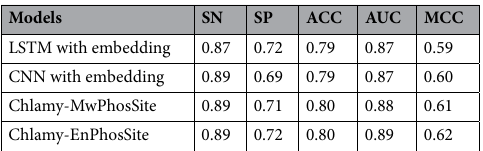
Table 6. Performance metrics of different models using an independent test dataset for S.